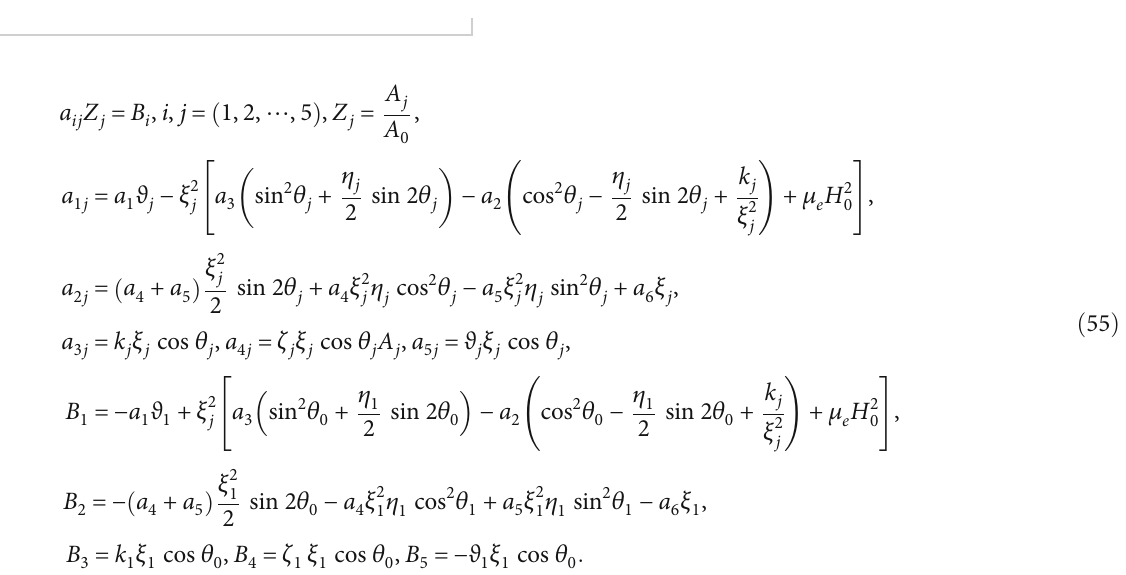
Figure 2: The various values of the amplitudes j z diverse values of the values of gravity g